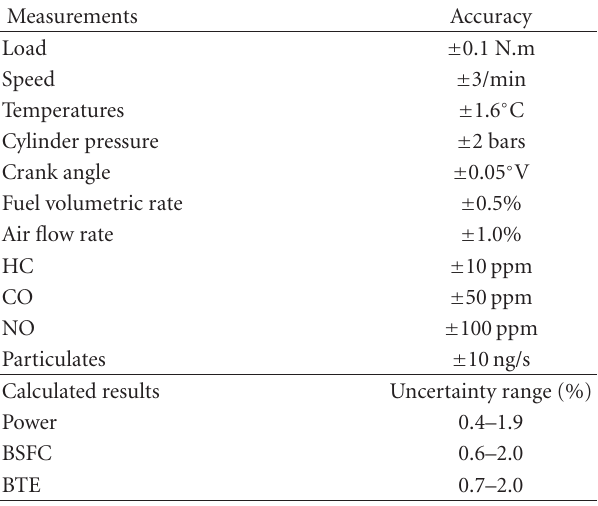
Table 2: The accuracies of the measurements and the uncertainties in the calculated